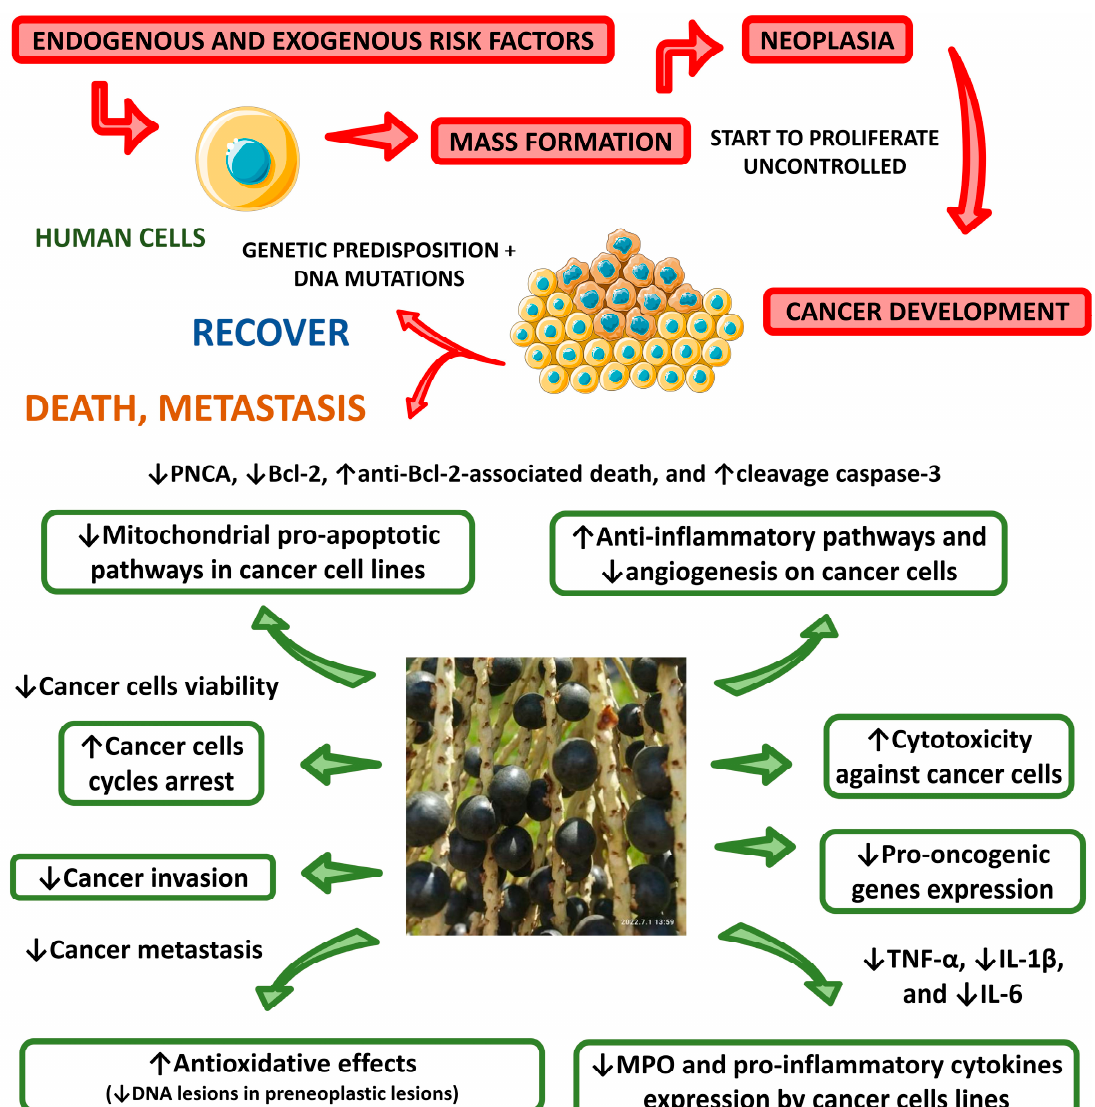
Figure 12. Potential anticancer effects of açaí. Açaí protects against neoplasia through cancer cell cycle arrest, direct cytotoxicity, and reduction of oncogenic gene expression. Due to these actions, açaí reduces cancer cell invasion, augments cancer cell apoptosis, and diminishes cancer cell angiogenesis. Symbols and abbreviations: ↑ : increase; ↓ : decrease; Bcl-2: B-cell lymphoma 2; IL-1 β : interleukin-1 β ; IL-6: interleukin-6; PNCA: proliferating cell nuclear antigen; TNF- α : tumor necrosis factor- α